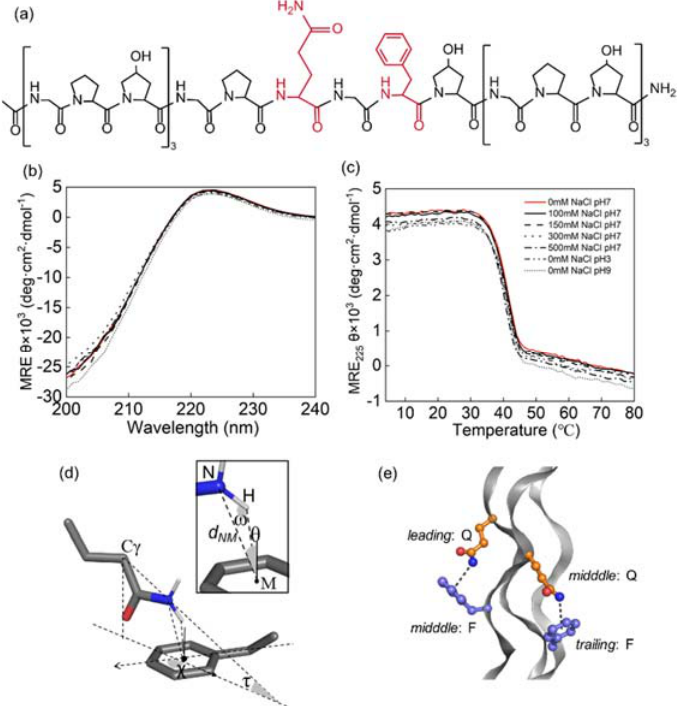
Figure 1. Experimental characterization and geometric description of Gln–Phe interactions: ( a ) primary sequence of the collagen-like peptide, [(GPO) 3 GPQGFO(GPO) 3 ] 3 is shown, where O represents (4R)-hydroxyproline. Gln and Phe are colored in red; ( b,c ) triple helix formation and stability of peptide GPQGFO were characterized by CD in 10 mM phosphate buffer under various NaCl concentrations and pH values as labeled in the plot. Wavelength spectra at 4 °C are shown in ( d ), and temperature melting experiments monitored at 225nm from 4 to 80 °C are shown in ( e ); ( d ) geometric parameters of an NH– π interaction in either a Q-F pair or an acetamide-toluene complex are defined. Three side ‐ chain ‐ position parameters, d C γ‐π , τ , and χ , describe relative position and orientation between Gln C γ‐ N ε (acetamide C ‐ N) and the phenyl plane. Inset on top ‐ right cor ‐ ner shows three bond conformation parameters, d NM , θ , and ω , describing how Gln N ε‐ H (acetam ‐ ide N ‐ H) is positioned relative to the phenyl ring center M; ( e ) the crystal structure of the collagen triple helices was solved (PDB ID:7VEG). Two closely contacted Q ‐ F pairs are shown in ball ‐ and ‐ stick representation. The chain identities are as labeled in figure ( d )–( e ), figures were generated with Pymol.